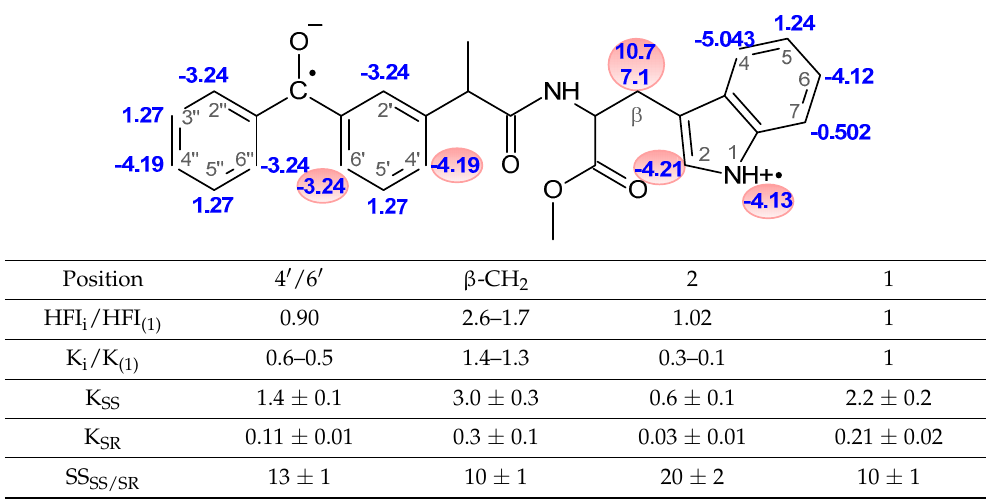
Table 3. The ratios of HFI constants and observed CIDNP coefficients (K) relative to 1-NH and the